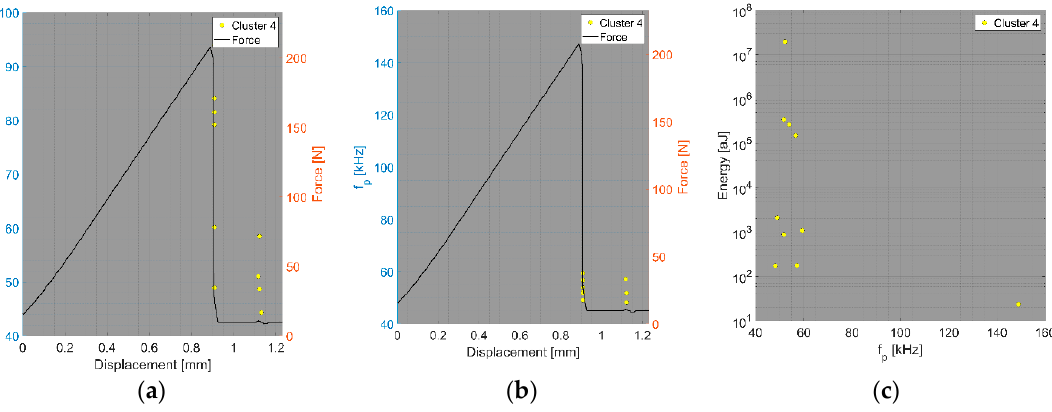
Figure 14. Clustering results for a BRCT representative sample using a spectral clustering algorithm (DWC dataset).